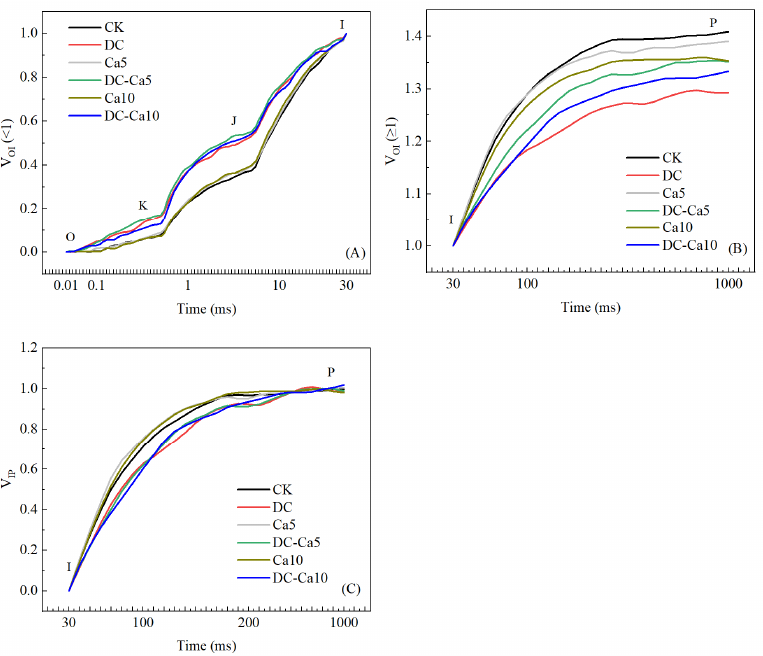
Figure 5. Variable fluorescence transients double normalized at Fo and F I : Vo I = (Ft − Fo)/(F I − Fo) ( A , B ) and at F I and F P phases: V IP = (Ft − F I )/(F P − F I ) ( C ).